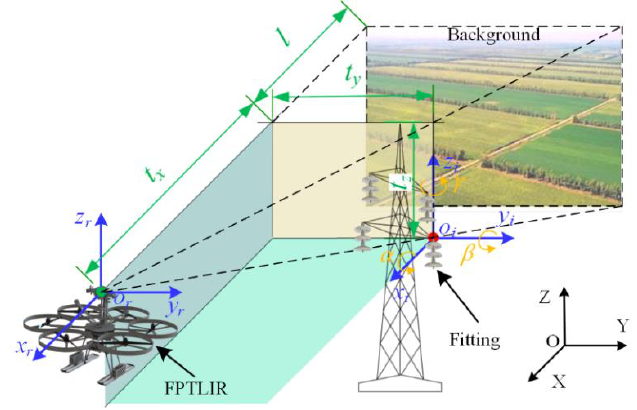
Figure 4. The position relationship between FPTLIR and fittings.